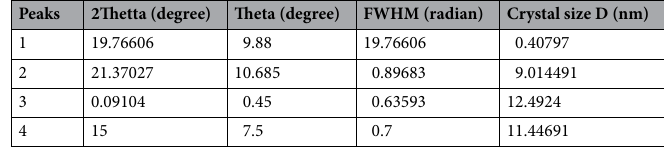
Table 1. Crystal structure parameters calculated from XRD graph.